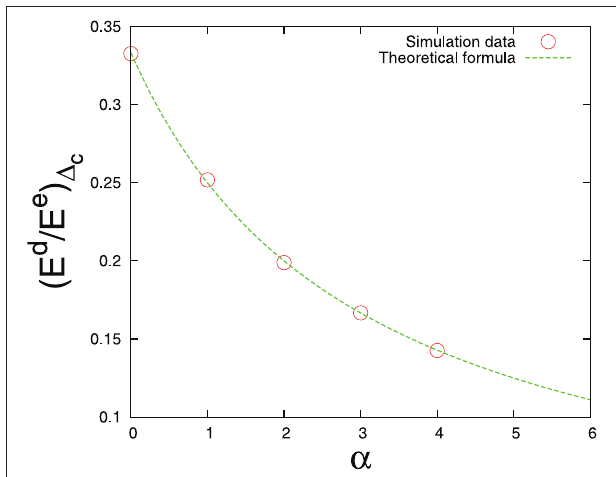
FIGURE 2 | Ratio between damage energy and elastic energy at the failure point 1 c vs. power law exponent α . Single bundle with N Dashed line is the theoretical estimate (Equation